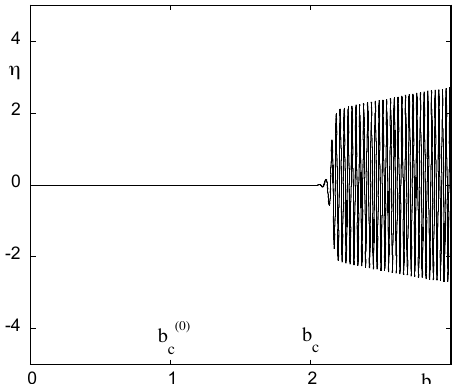
Figure 2. As in Fig. 1 but (cid:15) = 0 . 1.